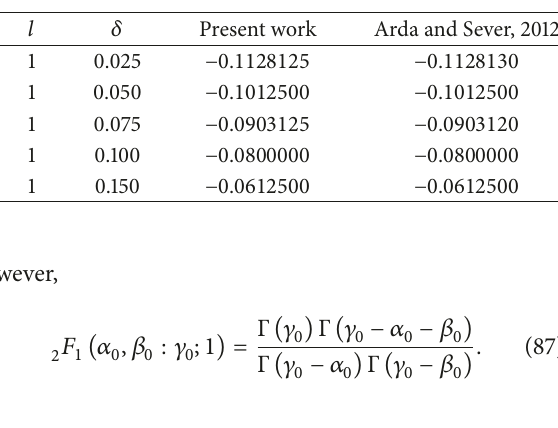
Table 18: Bound state energy of Hulthen potential in comparison to other